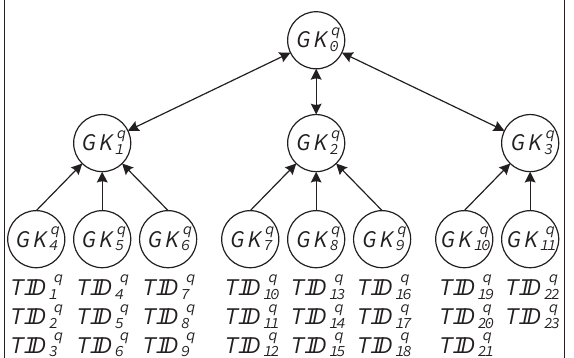
Figure 1. The 3-ary key tree for a group of